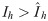
Typical pandemic scenarios for different average immunity loss times, ρ/τ ∈ {50, 93, 200, ∞}, corresponding to curves from right to left (or see color code), and different values for Ih, namely 0.01 in the top (a) graph and 0.0025 in the bottom (b) graph.Solid curves: S(t). Dashed curves: α(t). The fraction of acutely infected citizens is kept at Ih in phase II until herd immunity is reached (S = 1/R0, horizontal dashed line). If this is successful (if Ih>I^h, see Eq 30) phase III begins: Mitigation measures are being released (α = 0) and S(t) oscillates around its limiting value S∞ = 1/R0. Other parameters: R0 = 3, τ = 10 days.